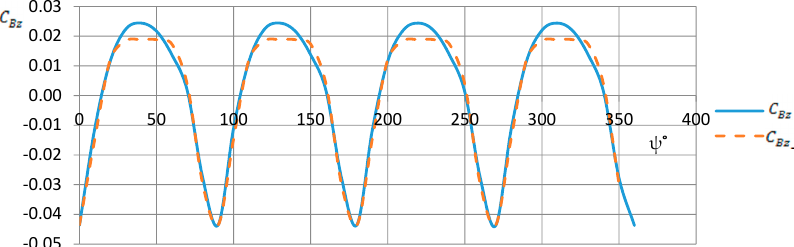
Figure 9. Main rotor thrust as function of the blade azimuth.